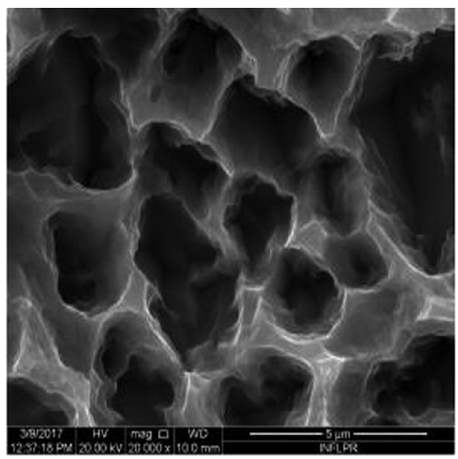
Figure 8: SEM image of sample S8 at a magni fi cation of 20k × .